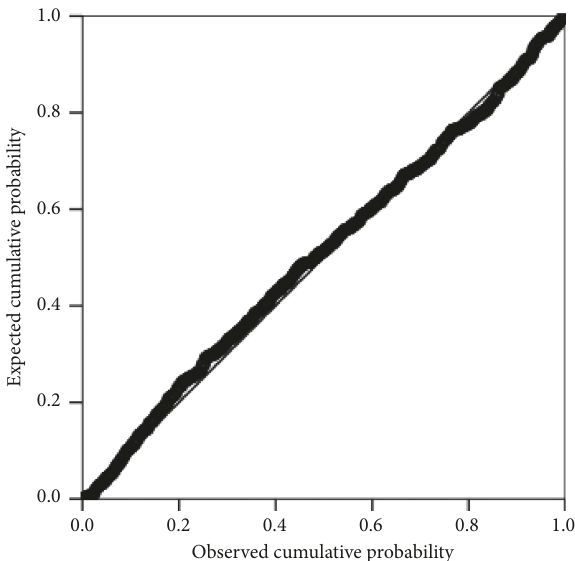
Figure 1: P-P plot of regression standardized